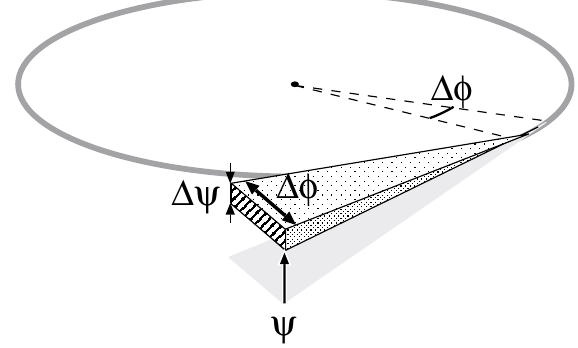
FIG. 3. Integration variables (cid:25) and used in the wattage- calculation formula (7). The circle indicates a circulating beam.